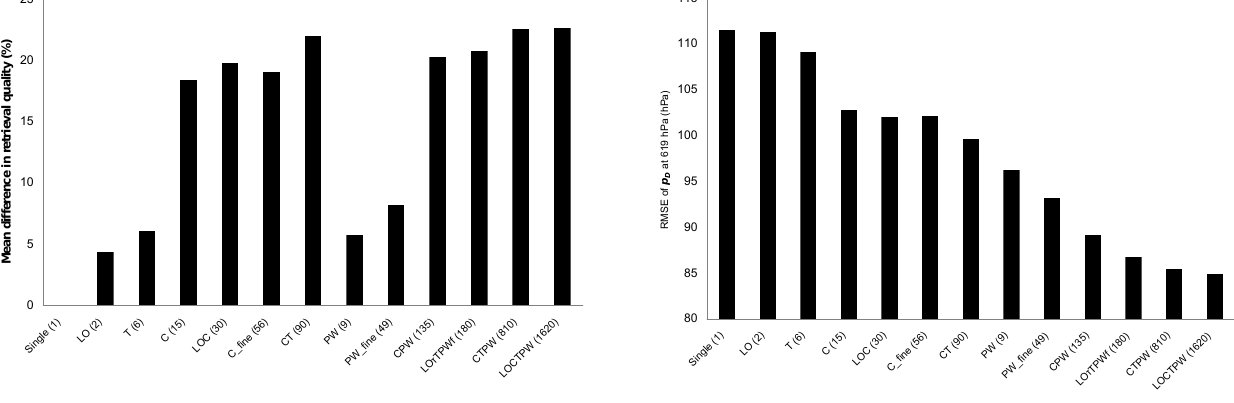
Fig. 9. RMSE of p D (height of peak HDO sensitivity) for the twelve categorizations, and the “Single” categorization. Numbers in paren- theses indicate the total number of categories within each catego-